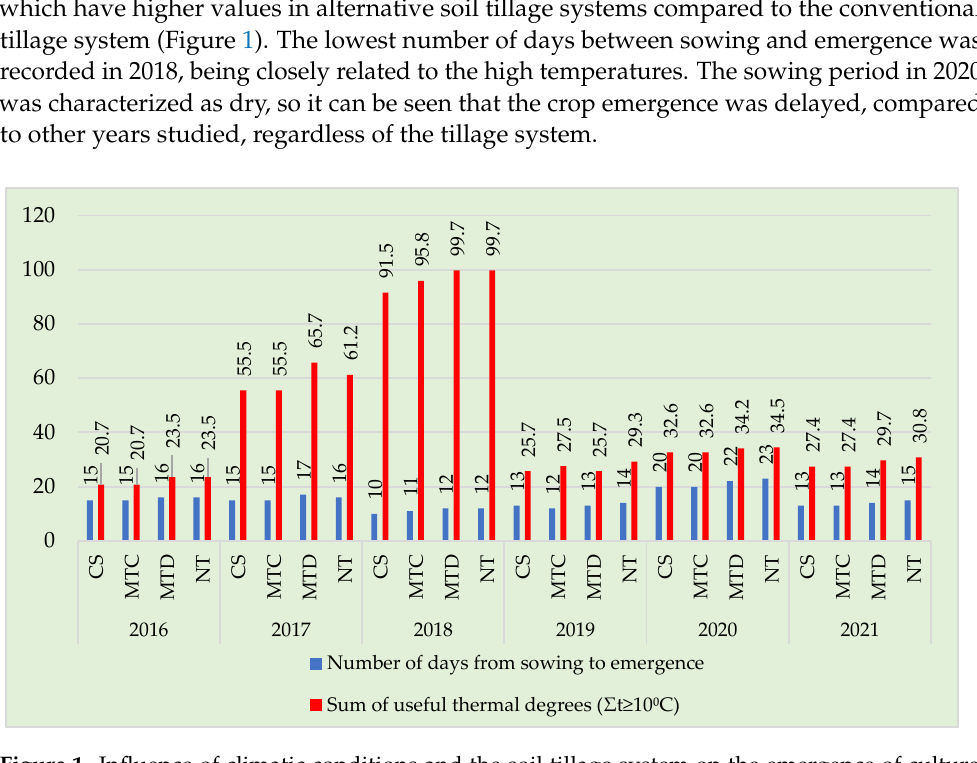
Figure 1. Influence of climatic conditions and the soil tillage system on the emergence of culture, 2016 – 2021. Notes: CS = Conventional System; MTC = Minimum Tillage — Chisel; MTD = Minimum Tillage — Disk; NT = No-Tillage.